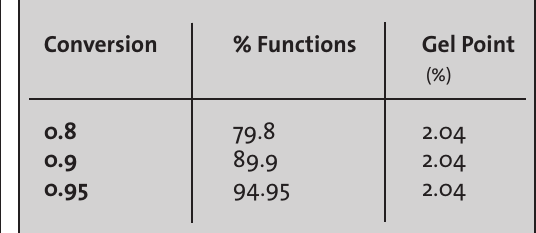
Table 3 (left): Influence of the side reaction due to residual monomers for chains with functionality f = 50 as a function of conversion of the polymerization reaction. Fraction of remaining reactive functions on copolymer chains after reaction of the residual monomer. Fraction of reacted functions at the gel point. Figure 3 (right): Storage modulus at 160°C as a function of frequency for a homogeneous blend ( (cid:122) ) compared to an unsheared heterogeneous blend ( (cid:139) ). For the first set of data ( (cid:122) ), the specimen has stayed 9 h at that